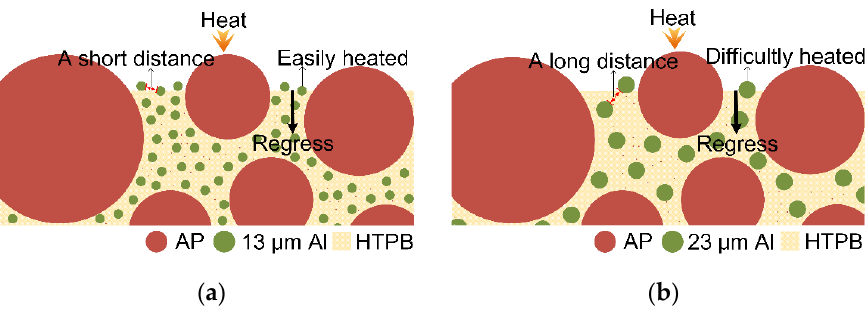
Figure 12. Diagram for the agglomeration mechanisms of ( a ) 13µm Al and ( b ) 23µm Al.